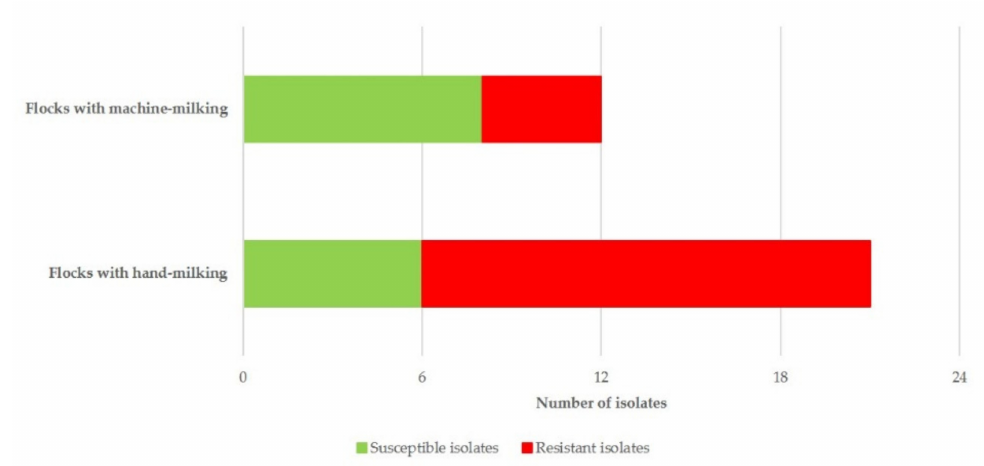
Figure 8. Frequency of recovery of S. epidermidis isolates from cases of ovine mastitis in Greece ( n = 33) in the MLST database according to antimicrobial agent susceptibility/resistance of the isolates and milking mode applied in the flocks. MLST: multi-locus sequence